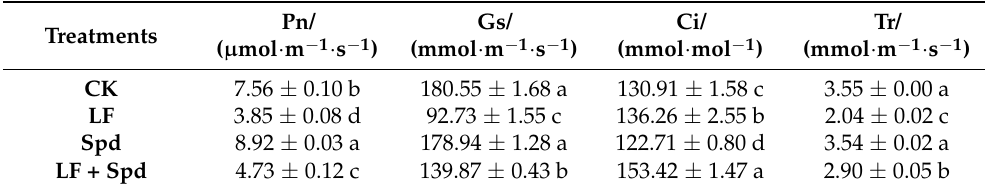
Table 4. Effects of exogenous Spd on photosynthetic parameters in tomato leaves under low- iron stress.